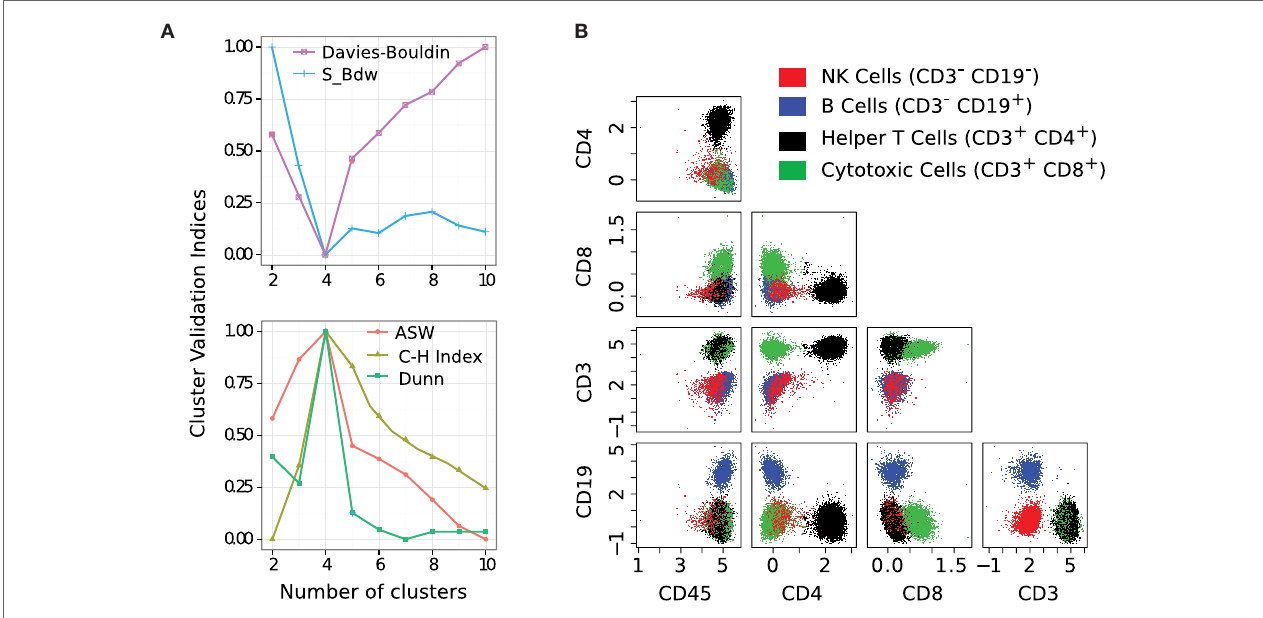
FigUre 7 | (a) Simultaneous optimization of five cluster validation criteria suggests that four cell populations are present in this sample. Here, three of the indices are maximized and two are minimized. (B) Bivariate projections of cell populations display four subsets of lymphocytes: red (natural killer cells), blue (B cells), black (helper T cells), and green (cytotoxic T cells). Each cell cluster is CD45 + since we pre-selected lymphocytes on the forward and side scatter